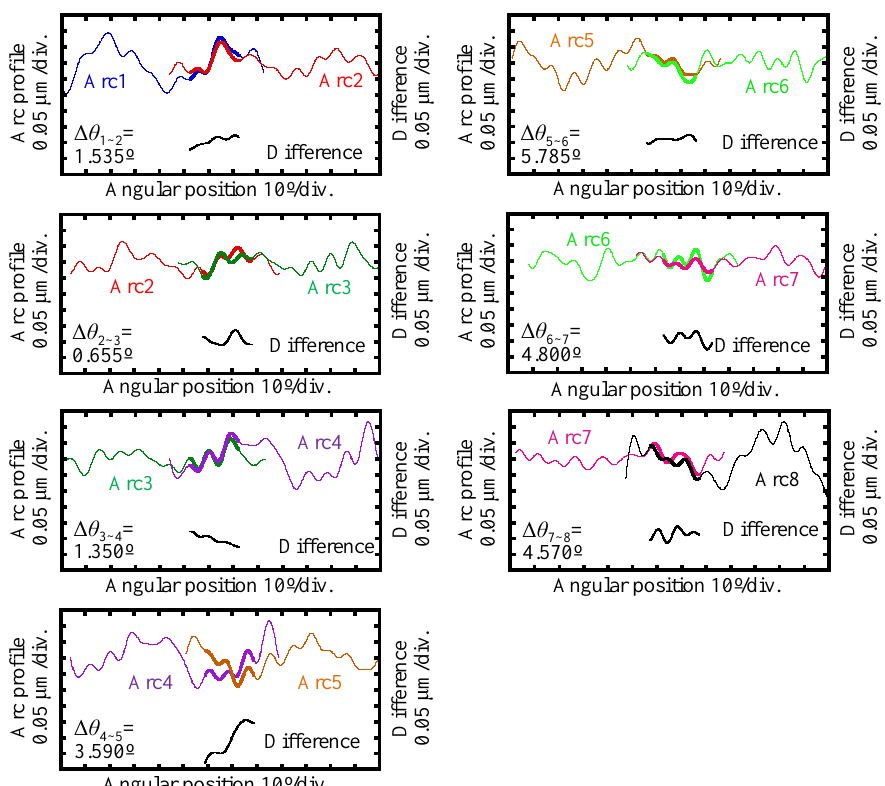
Figure 15. Stitched neighboring arc-profiles from the eight arc-profiles.